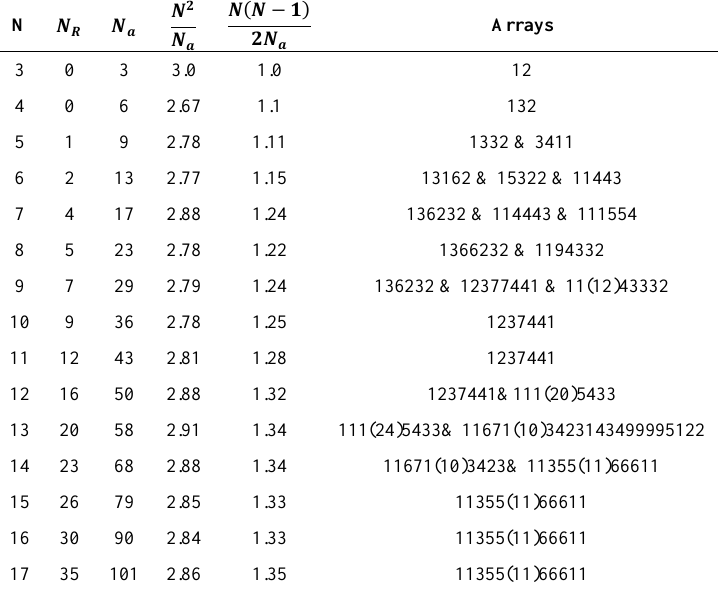
Table 3. Minimum Redundancy Linear